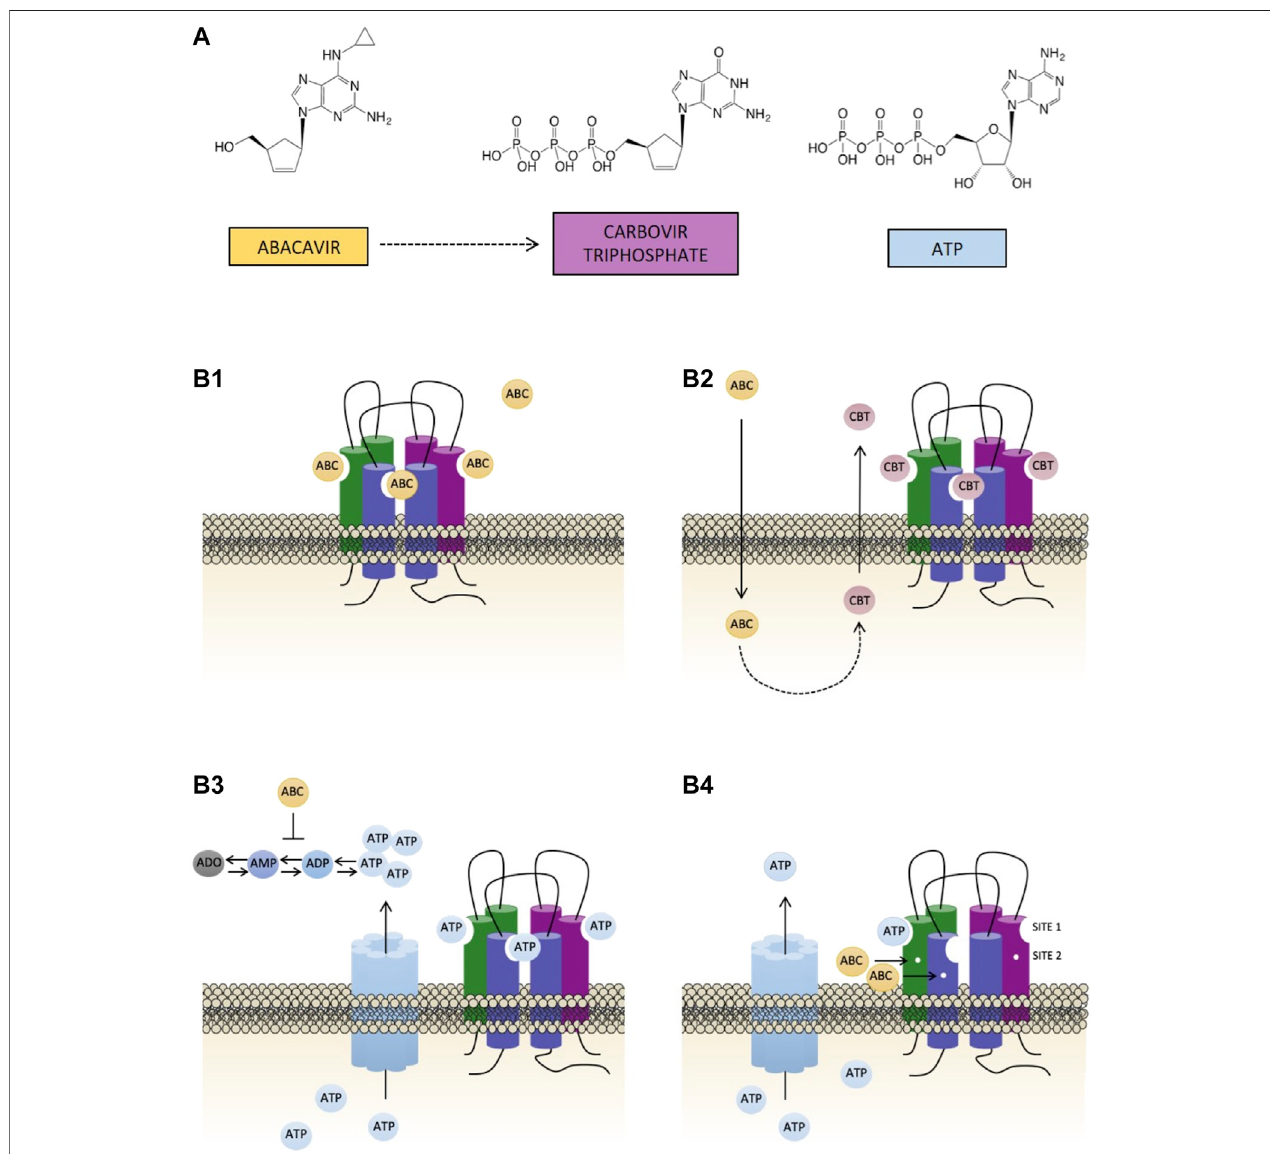
FIGURE 1 | Chemical structures of abacavir, carbovir triphosphate and ATP, and potential causes of the activation of P2X7R. (A) Abacavir (ABC), its active metabolite carbovir triphosphate (CBV-TP), and ATP share a close structural similarity. (B) The bottom part of the fi gure represents the four potential scenarios of the interaction of ABC with the P2X7R evaluated in the present study: (B1) direct activation of the P2X7R by ABC through its binding to ATP-binding sites; (B2) ABC is metabolized into its active metabolite CBV-TP, which subsequently stimulates the P2X7R by binding to ATP-binding sites; (B3) ABC indirectly stimulates the P2X7R, and ATPisthemolecule thatbindstoits bindingsites. ABCcouldinduce anenhancement inthelevelsofextracellular ATPeitherbyinterferingwiththeenzymes implicated in its synthesis/degradation or by mobilizing intracellular ATP to the extracellular space; and (B4) ABC allosterically modulates the activation of P2X7R. ABC binds to site 2, rendering this receptor more susceptible to direct activation by endogenous